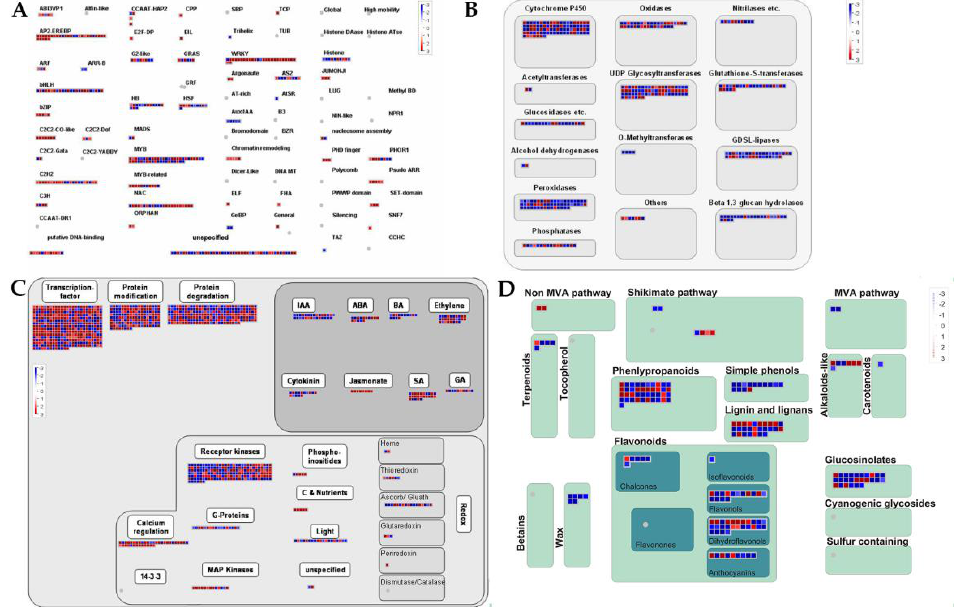
Figure 5. MapMan overview of changes in the expression of DEGs involved in transcription factor regulation ( A ), large enzyme families ( B ), plant growth regulation containing protein modification, protein degradation, plant hormones, and redox process ( C ), and the secondary metabolisms ( D ). Each square in A–D represents a separate DEG, red indicates that gene expression was induced and blue indicates that gene expression was repressed compared with the control.